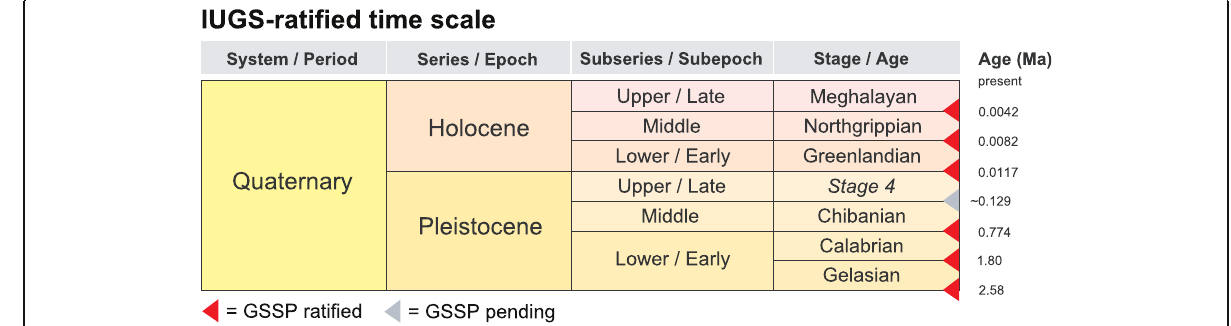
Fig. 1 The Quaternary System/Period and its official subdivision as currently approved by the ICS and ratified by the IUGS EC. Stage 4 corresponding to the Upper Pleistocene Subseries has yet to be officially defined. GSSP = Global Boundary Stratotype Section and Point (from Head et al. in